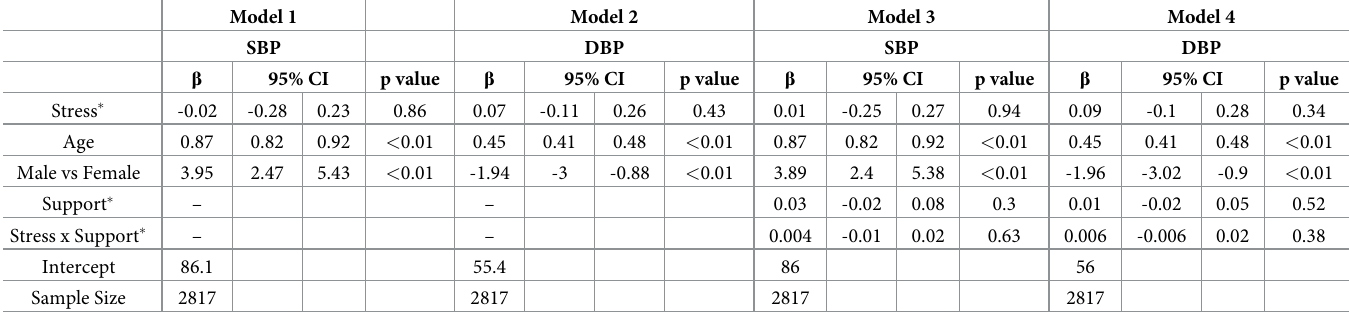
Table 2. Association of stress, support, systolic blood pressure and diastolic blood pressure by linear